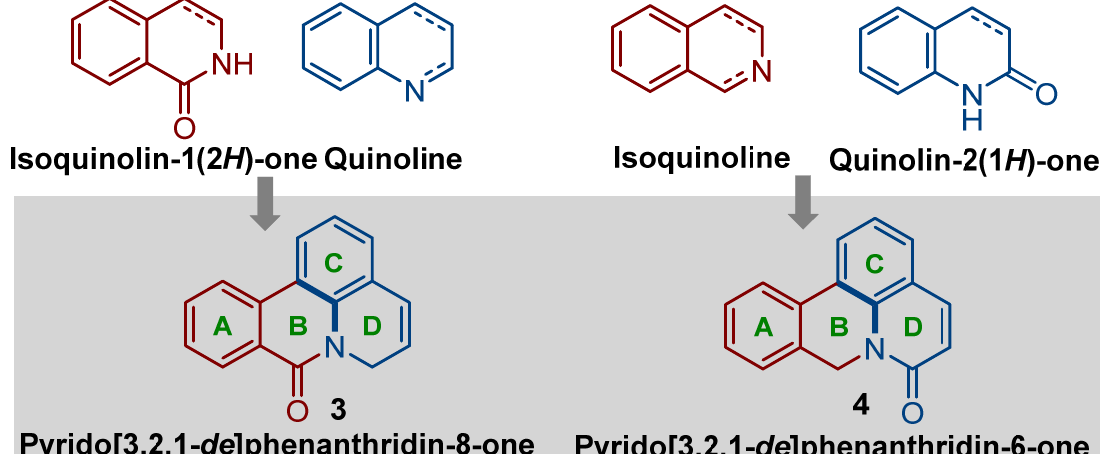
Figure 2. Pyridophenanthridinones 3 – 4 as promising nitrogen ‐ containing tetracyclic scaffolds.